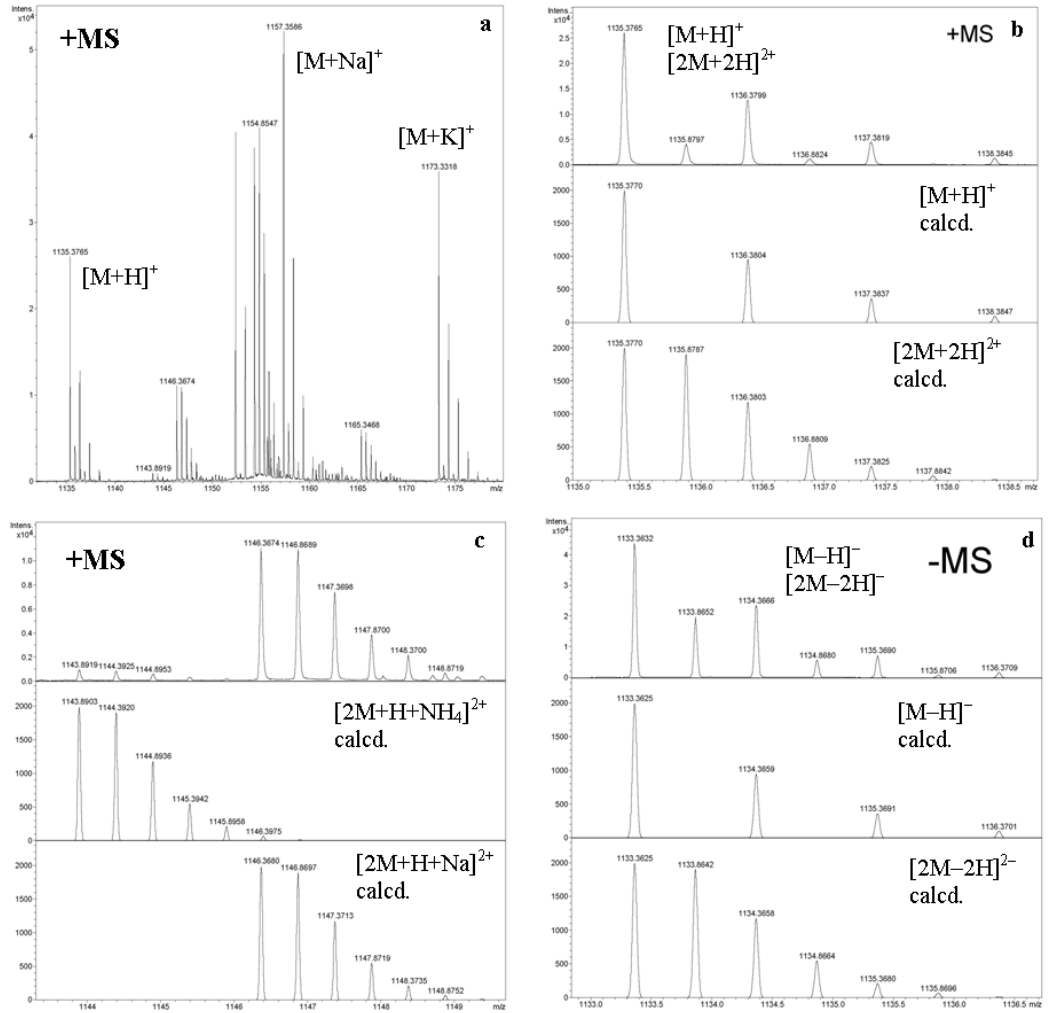
Figure 2. High-resolution ESI mass spectra of β -CD (the authors’ data). ( a ) Positive ion mode, range m / z 1130–1180; ( b ) same, extension m / z 1135–1138.7, ( c ) same, extension m / z 1143–1150; ( d ) Negative Figure 2 . High-resolution ESI mass spectra of  -CD (the authors' data). a . Positive ion mode, range m / z 1130—1180; b . same, extension m / z 1135— c . same, extension m / z 1143—1150; d . Negative ion mode, range m / z 1133—1136.5. calcd.: simulated profiles of isotopic clusters.